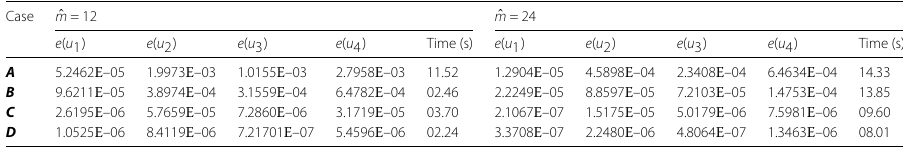
Table 3 The maximum absolute errors and the run time in Example 3 Case ˆ m